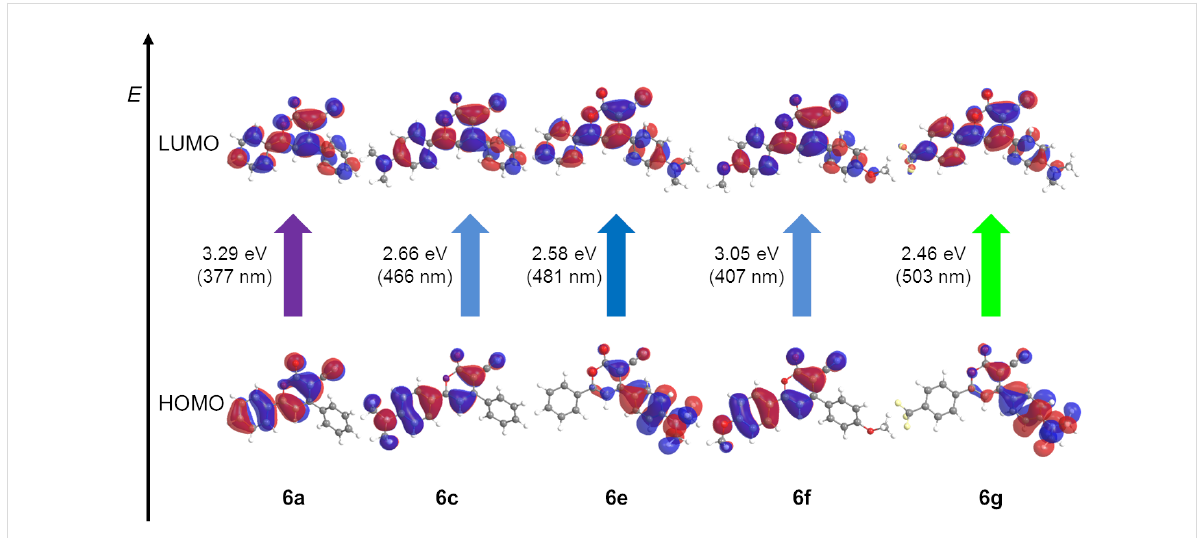
Figure 17: Selected DFT-computed (B3LYP 6-311G**) Kohn–Sham FMOs for 1 H -pyridines 6a , 6c , 6e , 6f , and 6g and representing contributions of the longest wavelength Franck-Condon absorption bands.